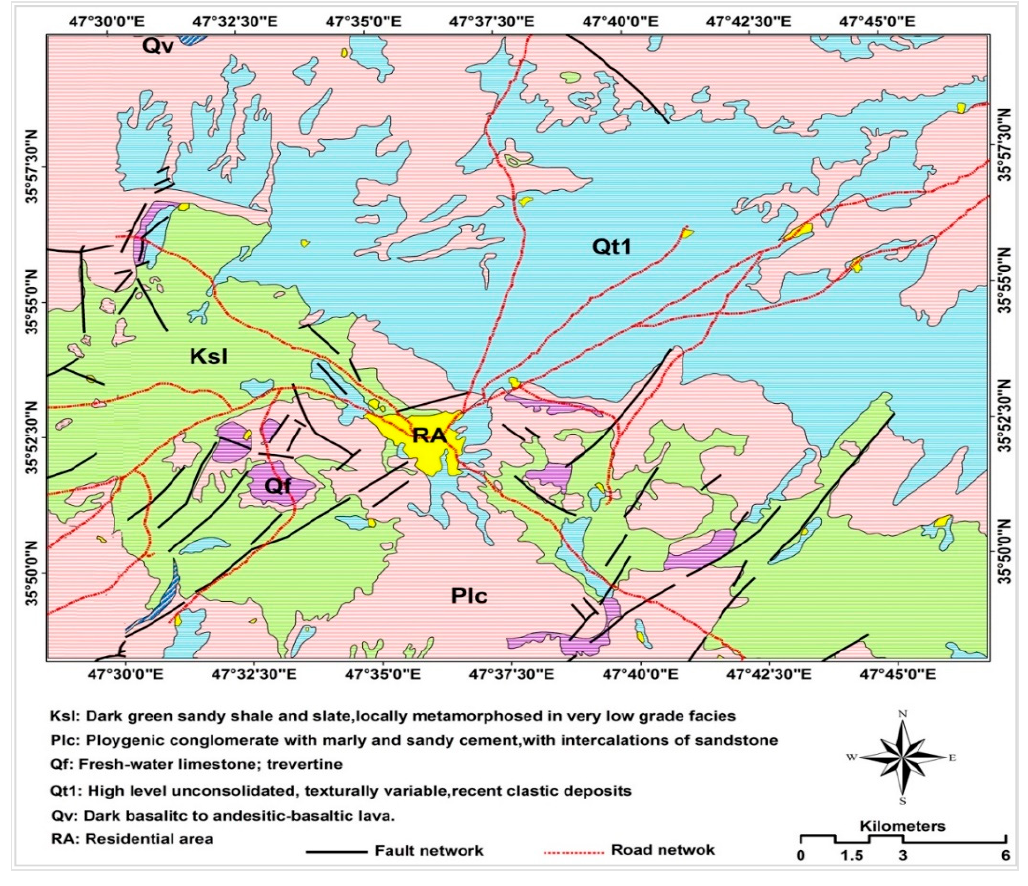
Figure 2. Lithological map of the study area.